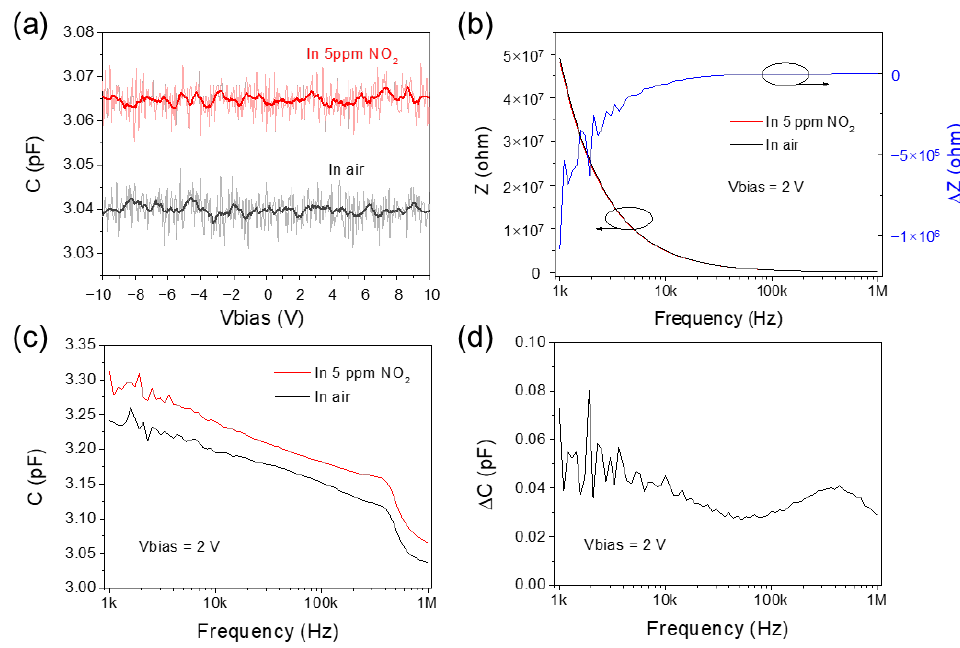
Figure 5. Electrical properties of PbS CQDs gas sensor. ( a ) C-V characteristics of PbS quantum dot gas sensor in air and 5 ppm NO 2 atmospheres at 1 MHz and bias voltage range of −10 V to 10 V; ( b ) Impedance-frequency curves of the PbS CQD film under air and NO 2 atmospheres at frequency range of 1 kHz to 1 MHz; ( c ) Capacitance-frequency curves of the PbS CQD film under air and NO 2 atmospheres at frequency range of 1 kHz to 1 MHz; ( d ) Capacitance response of PbS CQD gas sensor at different test frequencies (1 kHz to 1 MHz).